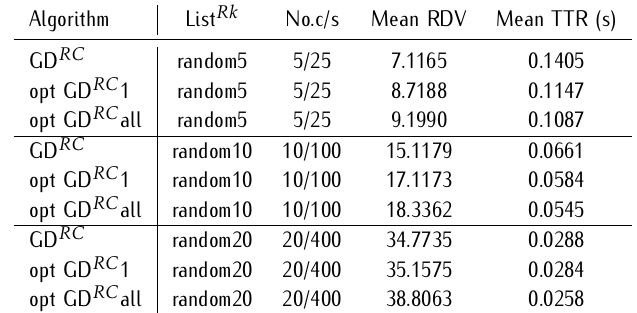
Table 7. Asynchronous CRs: Average (Mean) number of potential RDVs per cycle and average TTR (seconds) for optimized RAC 2 E- gQS with optimized slot allocation (a) for the best channel only (opt GD RC 1) (b) for all channels (opt GD RC all) in comparison with GD RC from Section 4; No.c/s stands for Number of channels / slots; List Rk is the channel ranking lists